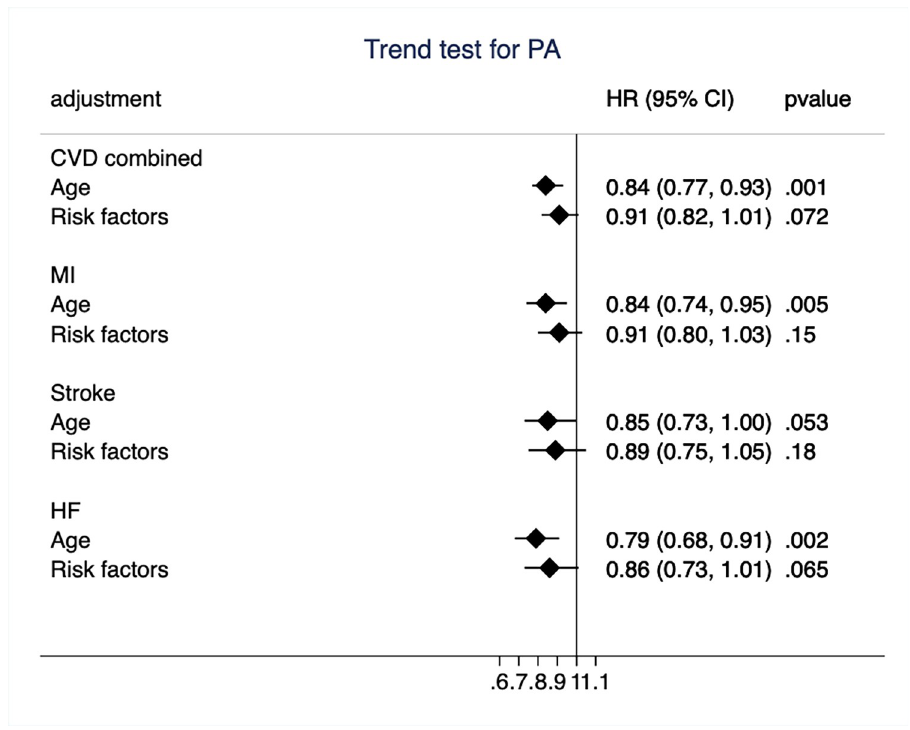
Fig 2. Hazard ratio (HR) and 95%CI for the trend test of physical activity (PA) for the combined end-point of cardiovascular disease (CVD) and the three CVD-components separately in models adjusted for age only and also for traditional risk factors. MI, myocardial infarction; HF, heart